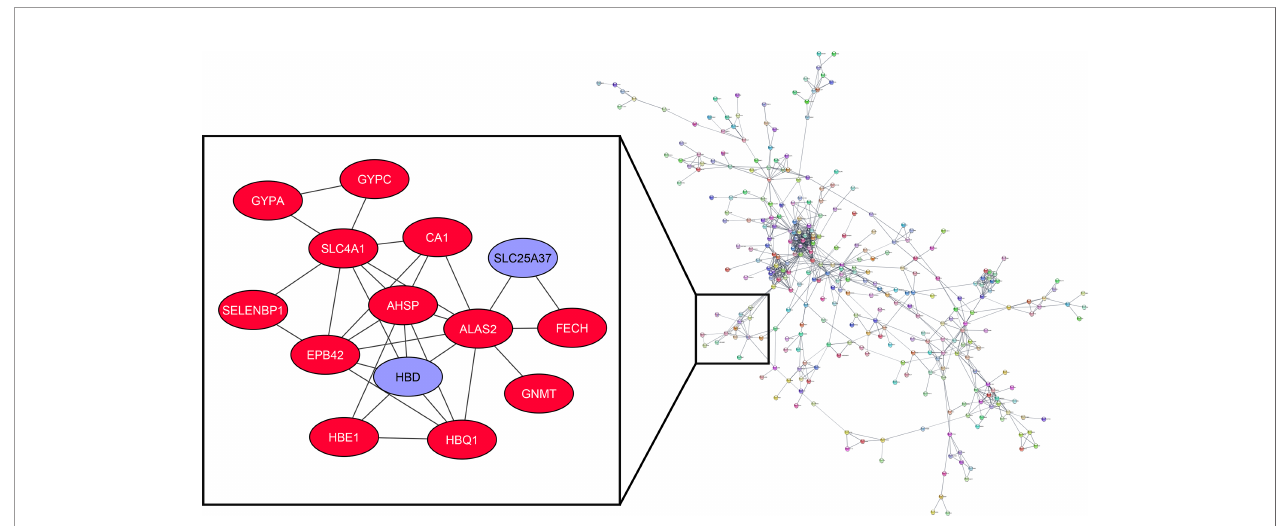
FIGURE 5 | Co-expression of hubs and PPI network of turquoise module members.